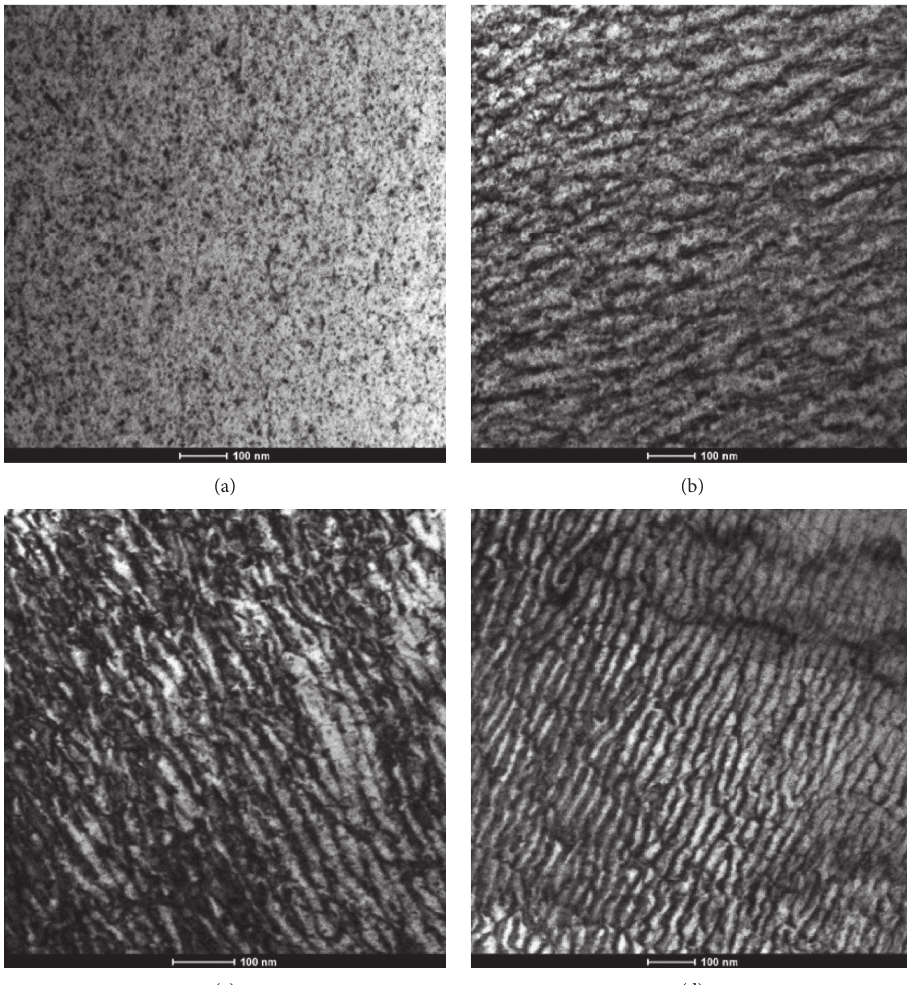
Figure 2: TEM micrographs of Hastelloy N after ion irradiation to a fluence equivalent to (a) 0.5dPa, (b) 2dPa, (c) 5 dPa, and (d) 10dPa.